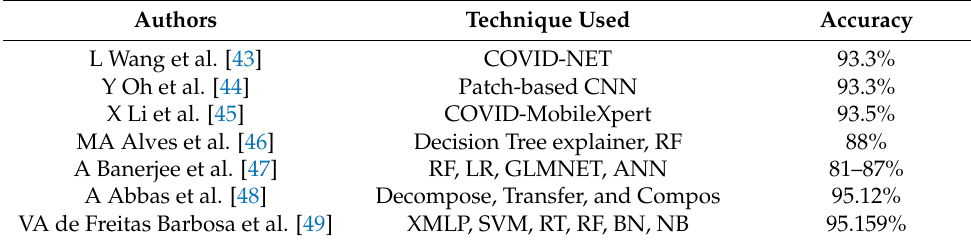
Table 1. Comparison of some other related